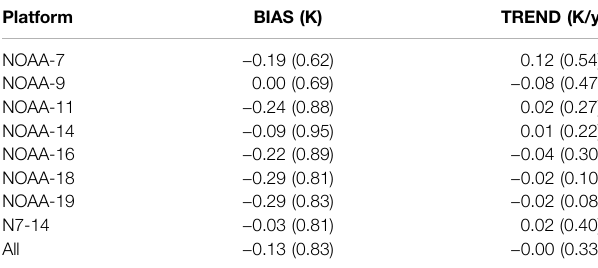
TABLE 5 | Statistical assessment of our orbital drift correction method in the real case for each NOAA platform, for NOAA-7 to 14 platforms, and overall: average value over all sites with its standard deviation in parentheses. TREND: the lineal trend of the difference between drifted and reference time series.